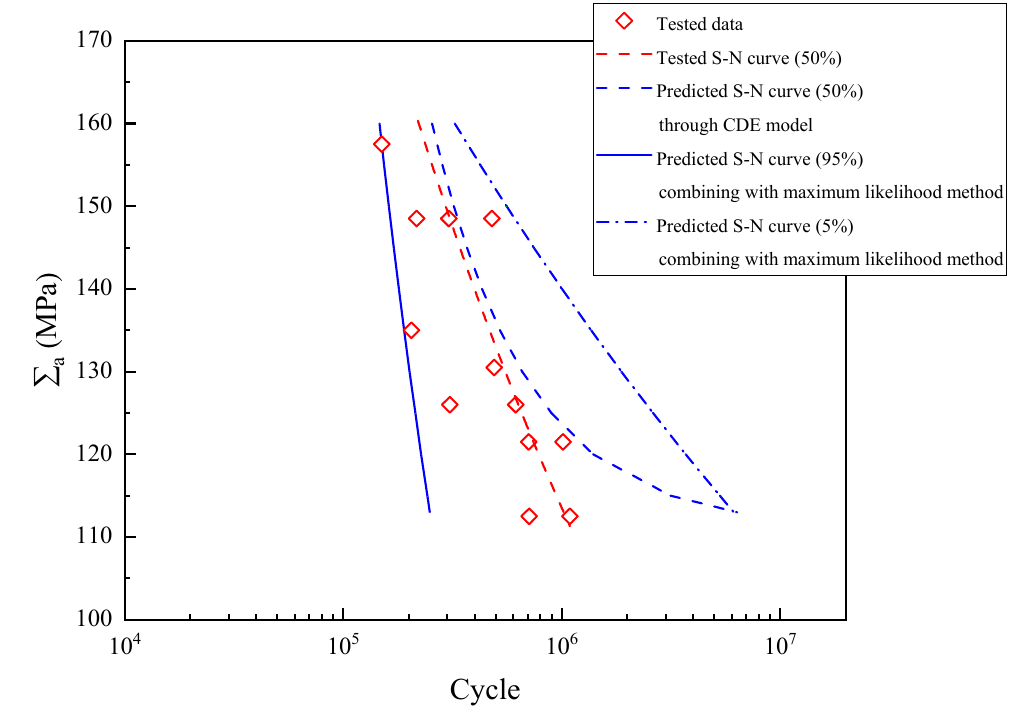
Figure 12. Comparison between predicted S-N curves and experimental data.